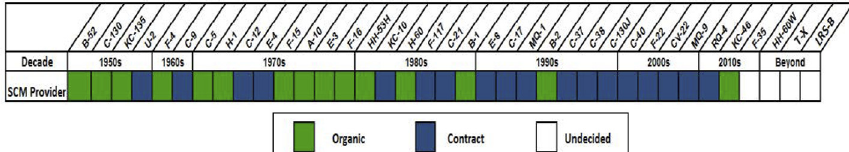
Figure 1. SCM provider by initial operational capability